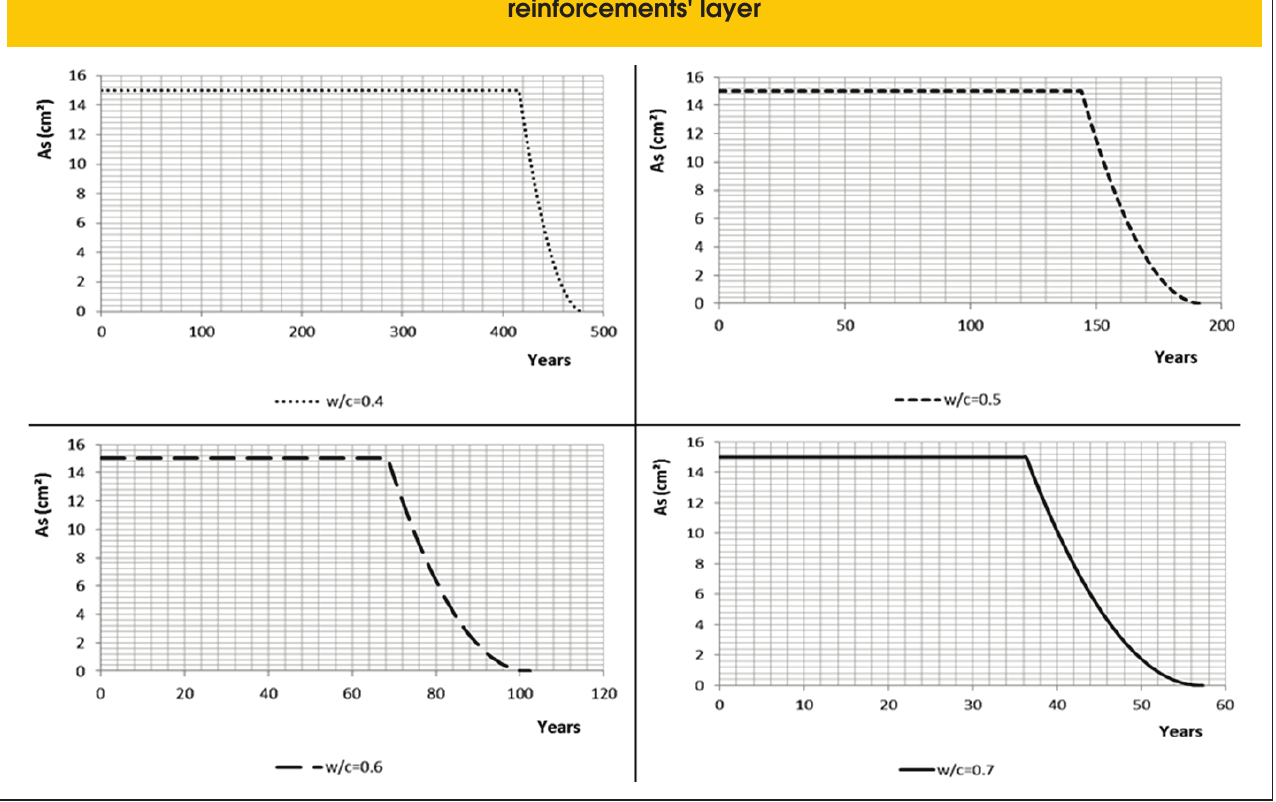
Figure 13 – Initiation and propagation periods considering CA II and β x=0.628